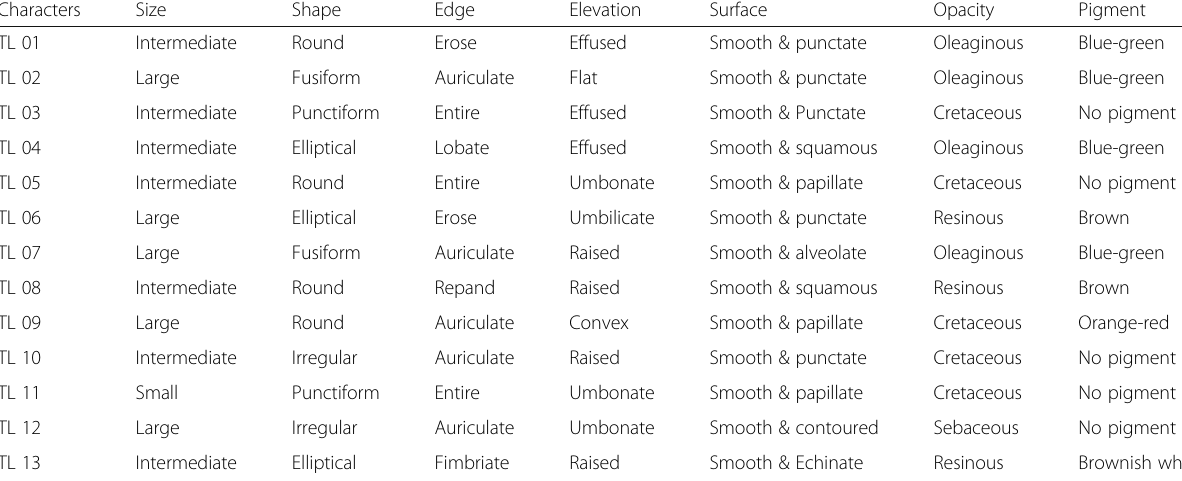
Table 2 Colonial morphology of bacterial isolates from used leech saliva